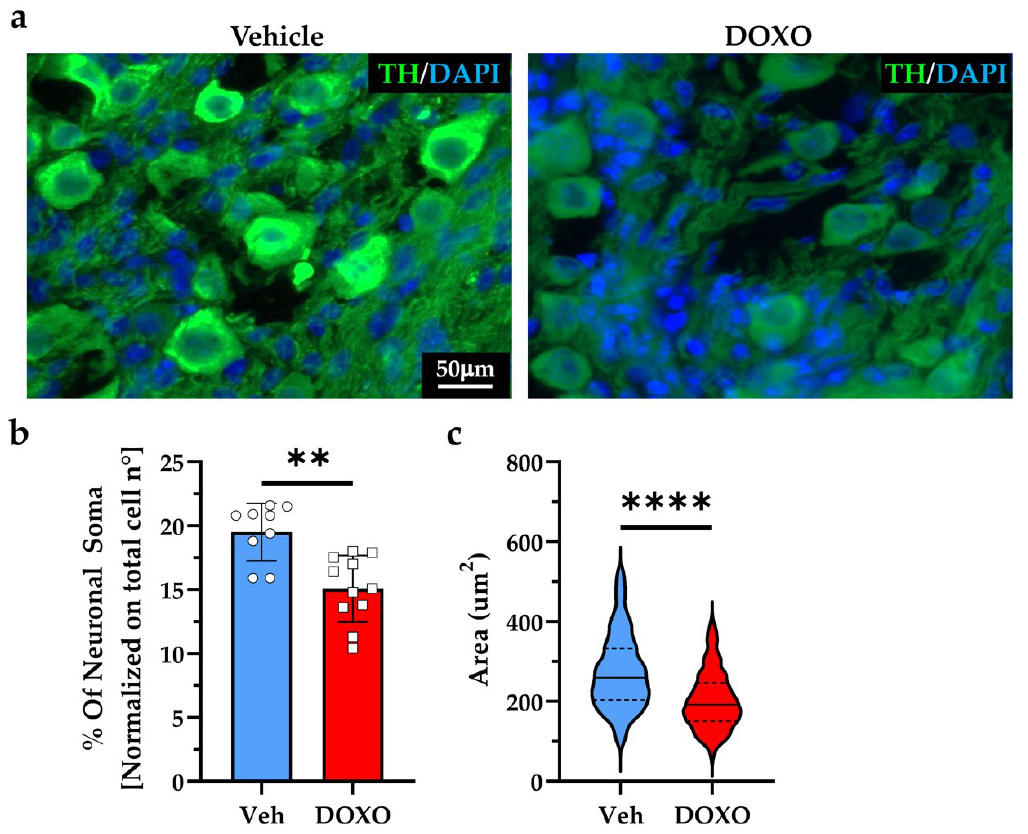
Figure 5. DOXO causes cardiac sympathetic neuron degeneration. ( a ) Immunofluorescence on stellate ganglia sections from the vehicle- vs. DOXO-treated mice. Slices were stained with an antibody to tyrosine hydroxylase (TH). Nuclei were counterstained with 4',6-Diamidino-2-Phenylindole (DAPI). ( b , c ) Quantification of the fraction of neuronal soma/total cell number ( b ) and the mean area of the sympathetic neuron (SN) cell bodies ( c ) in the stellate ganglia of the DOXO- vs. vehicle-treated mice. Bars represent the s.d. Differences among the groups were determined using a Mann–Whitney test. (n > 500 cells from nine independent images/group from three different mice; **, p < 0.01; ****, p < 0.0001). DOXO, doxorubicin; Veh, vehicle.